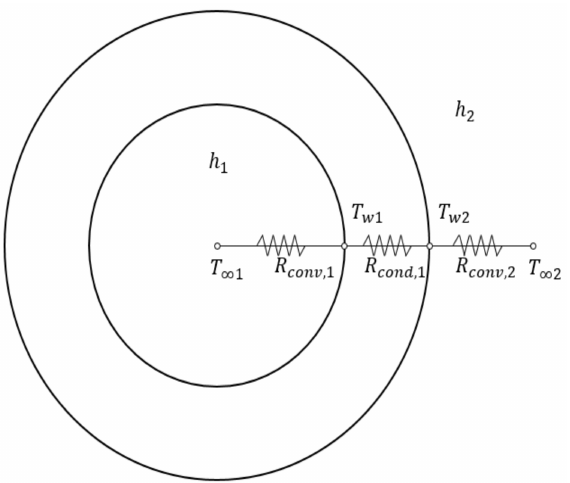
Figure 7. Temperature differences of the wall reference on the side of the hydrogen storage tank.